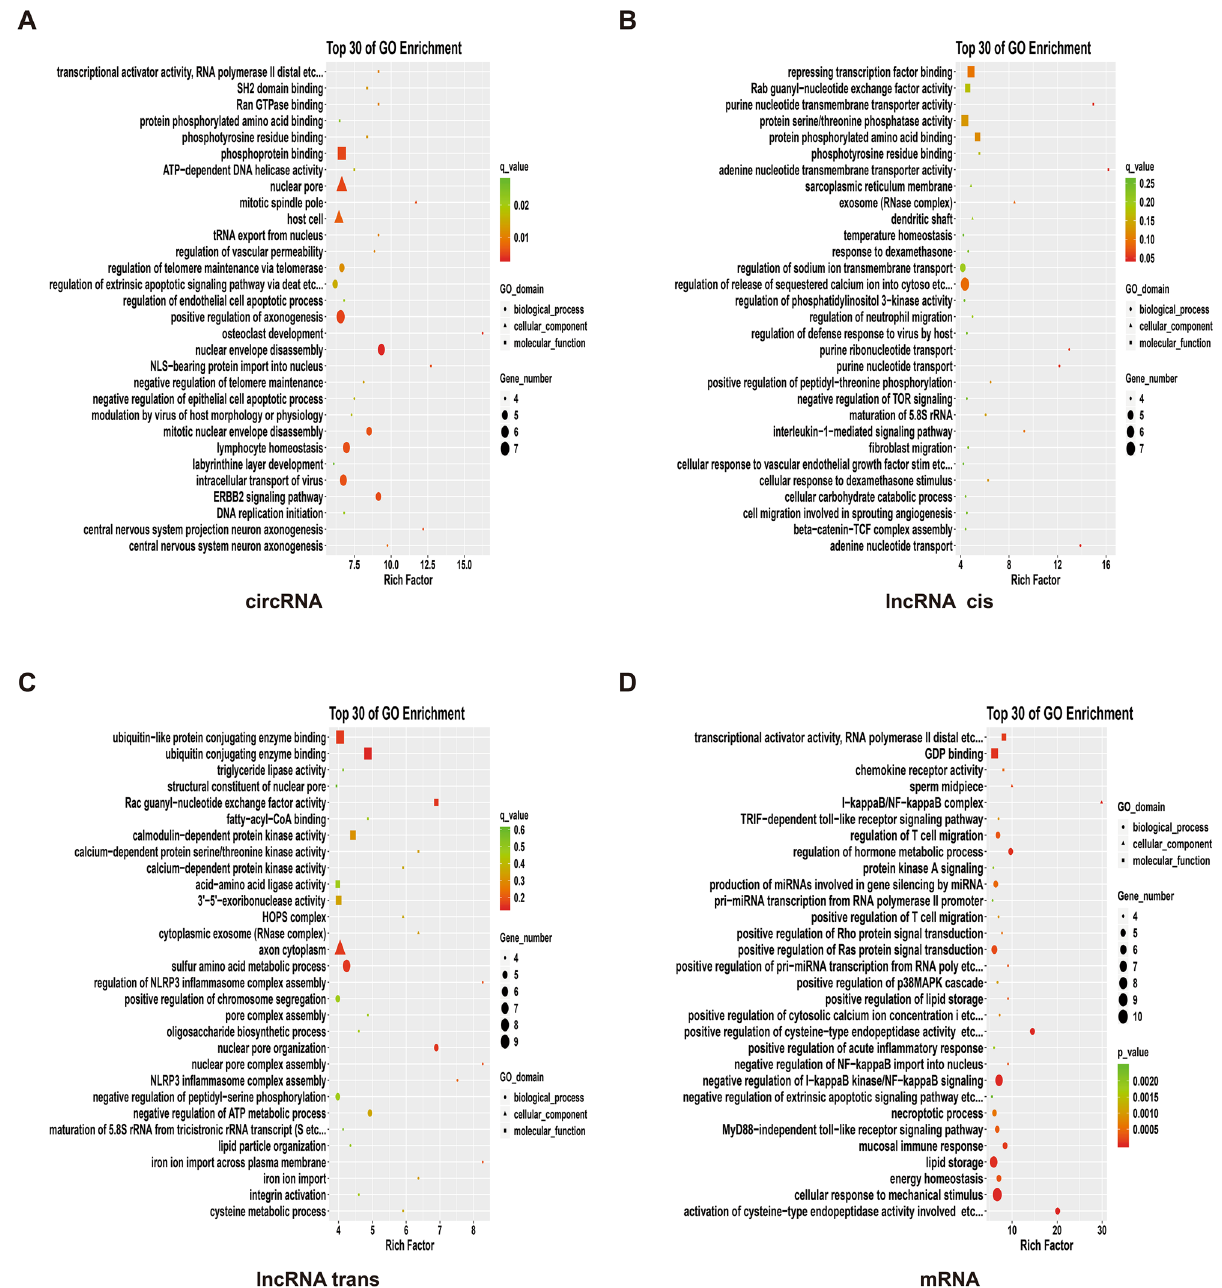
Figure 2. GO enrichment result. ( A ) circRNA; ( B ) lncRNA cis; ( D ) lncRNA trans; ( D ) mRNA. The employed methodology is Fisher precision verification. Data package is clusterProfiler, from R (version 3.4.3); the selection standards include that the differential gene count dropped on certain term is not less than 2, and p value is smaller than 0.05. The term in the drawing is arranged in descending order of size according to the value of an enrich factor, and takes the first 30 results. Samples are from 3 recurrent COVID-19 patients and 3 healthy GO and KEGG functional enrichment. In the GO and KEGG processes, the enrichment analysis was performed on the function of the parent gene of circRNA, while on the function of lncRNA aided by its target gene, and on the function of the gene of mRNA, respectively. As shown in Fig. 2, the main differentially expressed circRNA functions ranked among top 30 in the GO enrichment analysis are as follows. The first aspect is its impact on signaling pathways, such as the central nerv- ous system neurons and the formation of the projection neurons axon, and the ERBB2 signaling pathway, and the function of SH2 domain and so on, which further affect the signal transmission. The second aspect is the impact on protein formation and processing, such as phosphorylation, the transport of tRNA from the nucleus